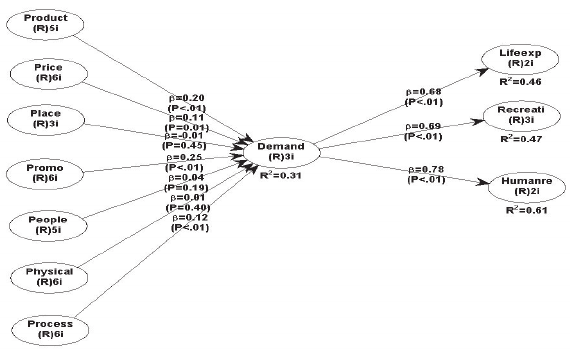
Fig. 3. Result of the confirmatory factor analysis Cross construct correlation